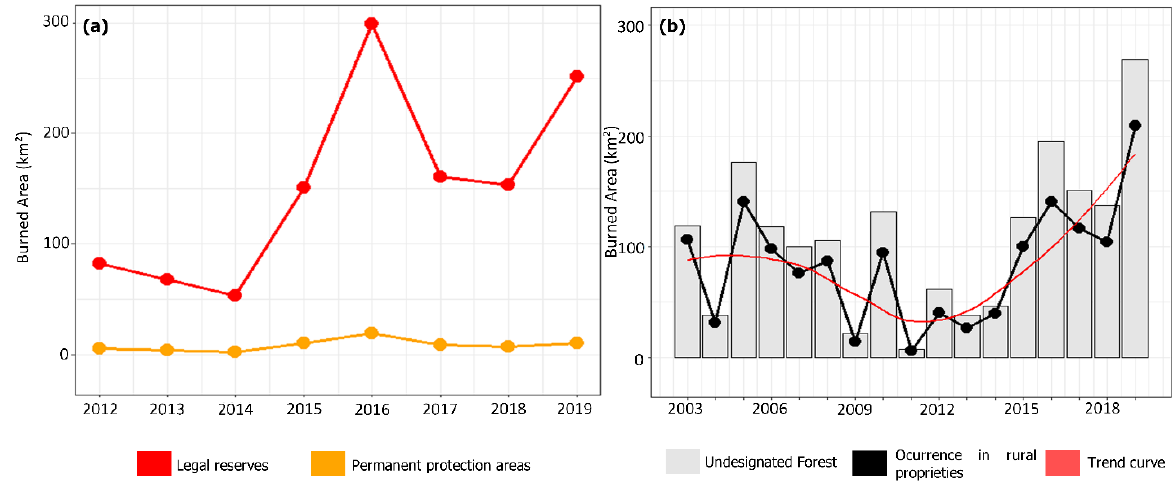
Figure 8. ( a ) Burned area in legal reserves and permanent preservation areas in the study region from 2003 to 2019 and ( b ) burned area in the undesignated forest and fire occurrence attributed to “rural properties.”.